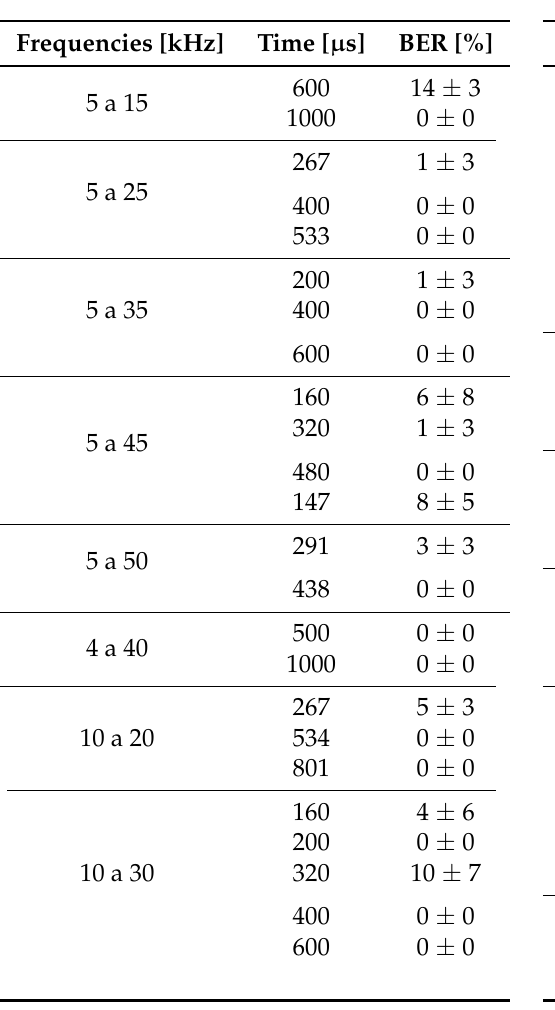
Table 3. BER of the Sine-Sweep for modulation for a set of measured